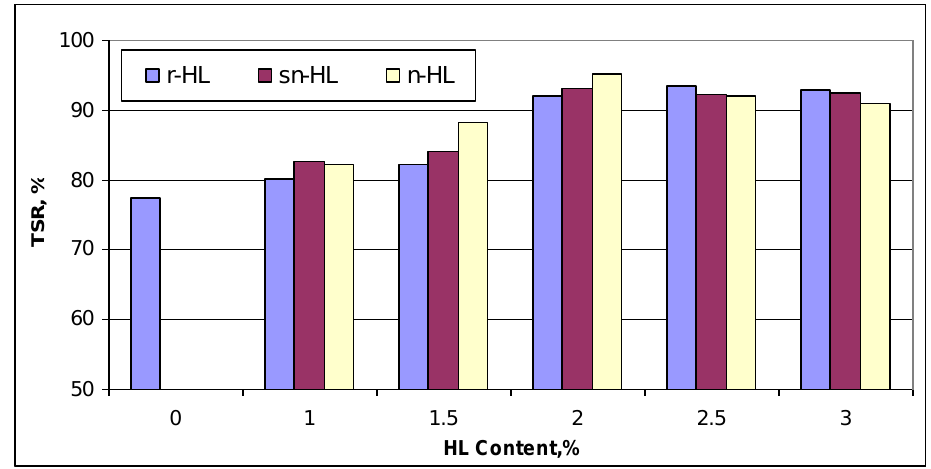
Figure 14. The indirect tensile strength ratio.